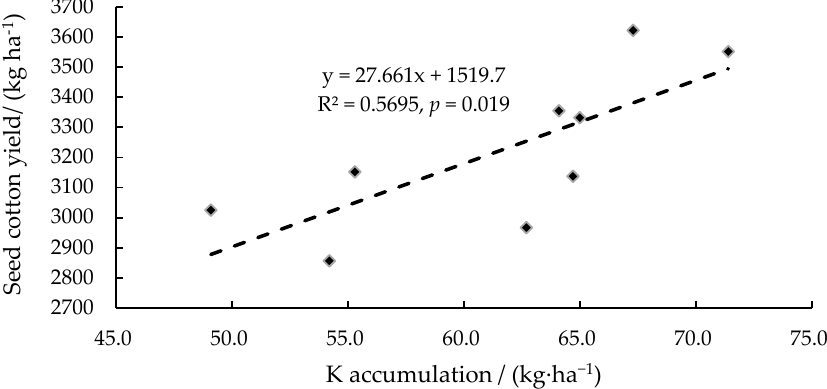
Figure 4. Relationship between seed cotton yield and K accumulation during full flowering stage-boll opening stage.